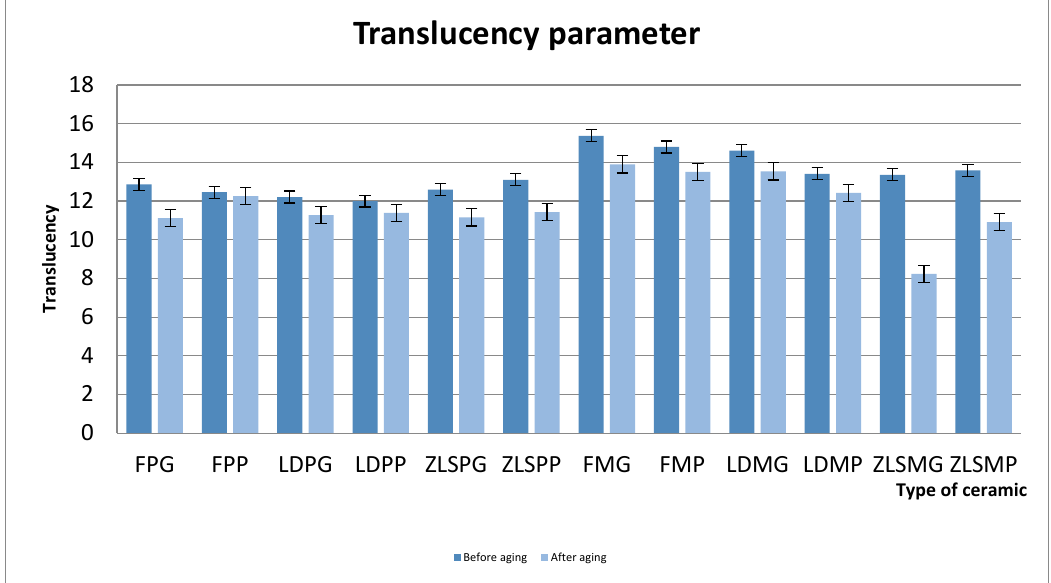
Figure 1. Mean values for the translucency parameter before and after thermocycling. Table 5. TP values before and after thermocycling.